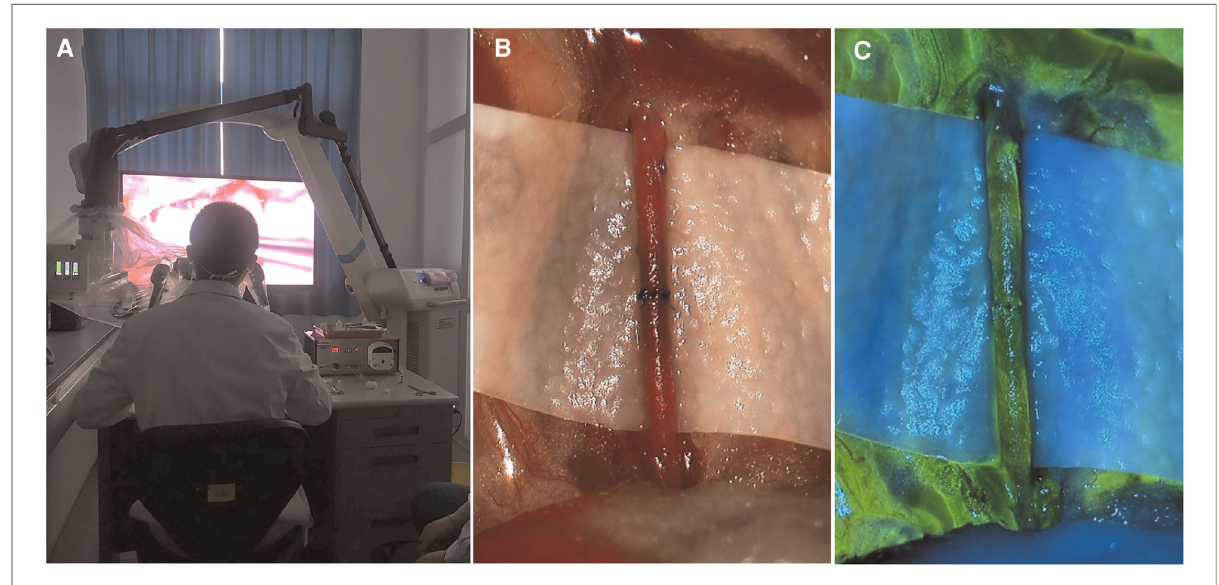
FIGURE 2 Real scene with 3D exooscope. ( A ) Real scene of operator anastomosis using a 3D exoscope. ( B ) Real situation of anastomotic blood vessel using a 3D exoscope. ( C ) Sodium fl uorescein video-angiography for patent anastomotic vessels using a 3D